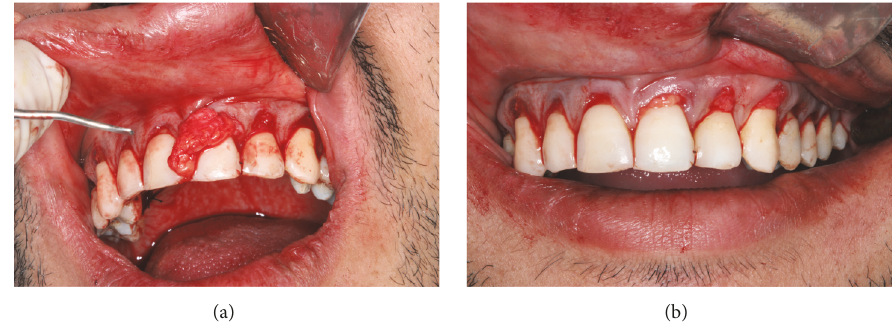
Figure 6: (a) Inserted graft on the recipient site. (b) Graft positioned on the recipient site.